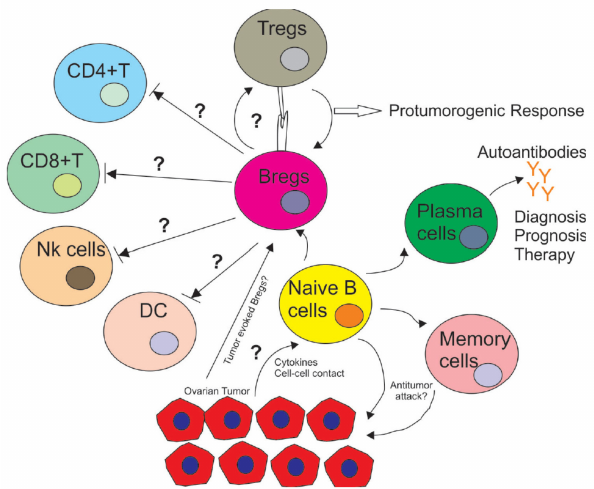
Figure 1. Immuno-regulatory role of B cells in the tumor microenvironment in ovarian cancer. The tumor microenvironment induces naïve B cells to di ff erentiate into subsets, such as Bregs, plasma cells and memory B cells. These subsets play di ff erent roles as Bregs inhibit the proliferation of CD4 + T cells, CD8 + T cells, DCs and NK cells while supporting the proliferation of immune-inhibitory Tregs with unknown cytokines and cell–cell contacts. On the other hand, some subsets of B cells whose markers are unknown also induce an anti-tumor response with CD8 + TILs, inhibiting tumor progression. Plasma cells secrete autoantibodies that can play a variety of roles in cancer diagnosis, prognosis and therapy. It is unknown if autoantibodies can also support tumor